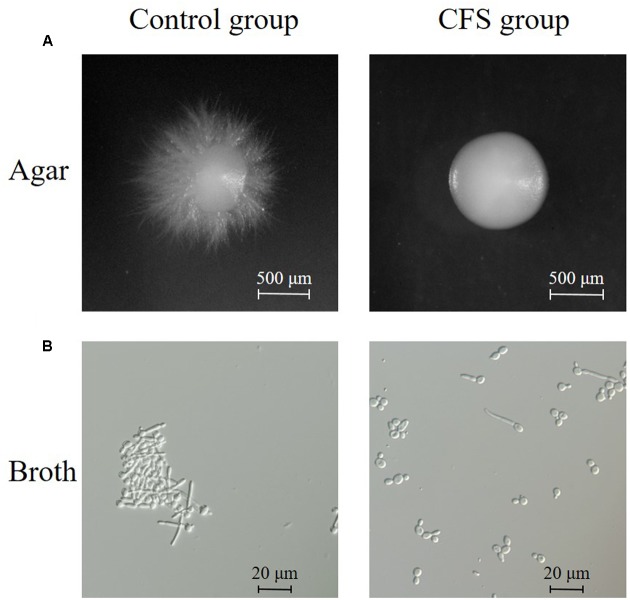
Inhibition of hyphal formation by CFS. (A) Effect of CFS on C. albicans hyphal formation on solid RPMI 1640 + 10% FBS medium. Plates were incubated at 37°C for 5 days. Images of colony edges were obtained using a stereomicroscope, original magnification: 6.6×. (B) Effect of CFS on C. albicans hyphal formation in liquid RPMI 1640 + 10% FBS medium for 4 h at 37°C. Images of cellular morphology were obtained using a light microscopy, original magnification: 400×.